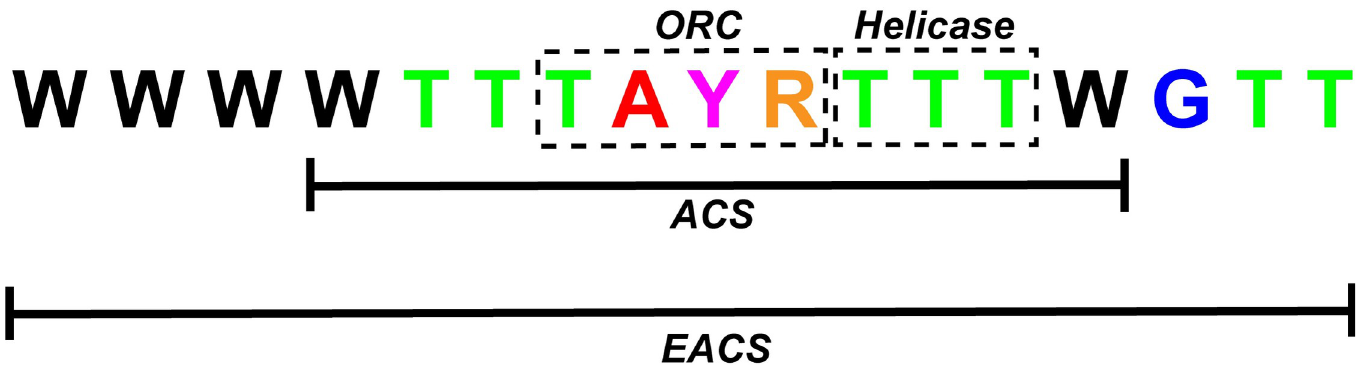
Fig 7. Extended autonomous consensus sequence (EACS) presented in [33]. The core autonomous consensus sequence is highlighted with the TAYR motif highlighted as the origin of replication complex binding site (ORC) and the TTT motif highlighted as a helicase binding site. ‘W’ denotes A or T, ‘Y’ denotes C or T, ‘R’ denotes G or A.